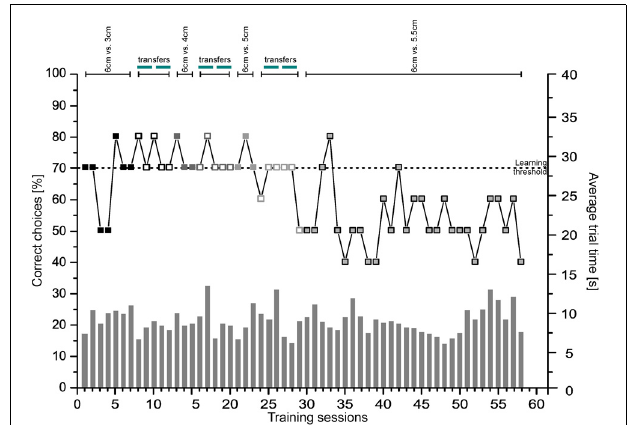
FIGURE 9 | Size pairs. Shown is the performance of Shark 3 as the percentage of correct choices per session (symbolized by boxes; left ordinate) as well as the average trial time (s) per session (symbolized by gray bars; right ordinate) per phase until the learning criterion was